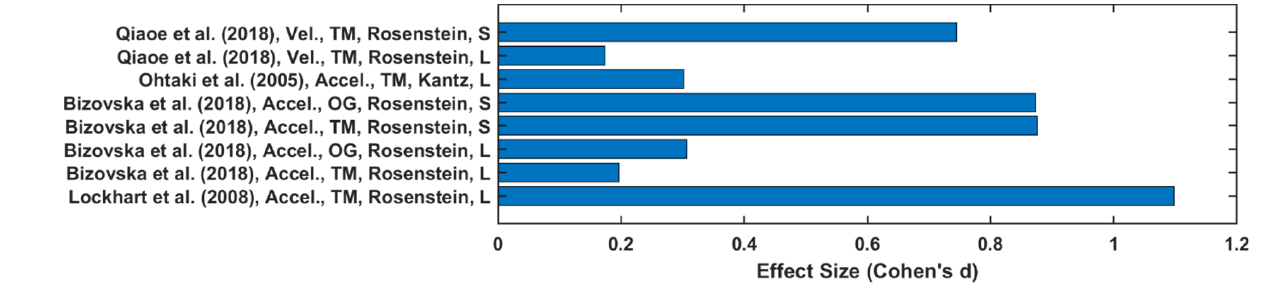
Figure 4. Effect size of LyE between younger and older groups.